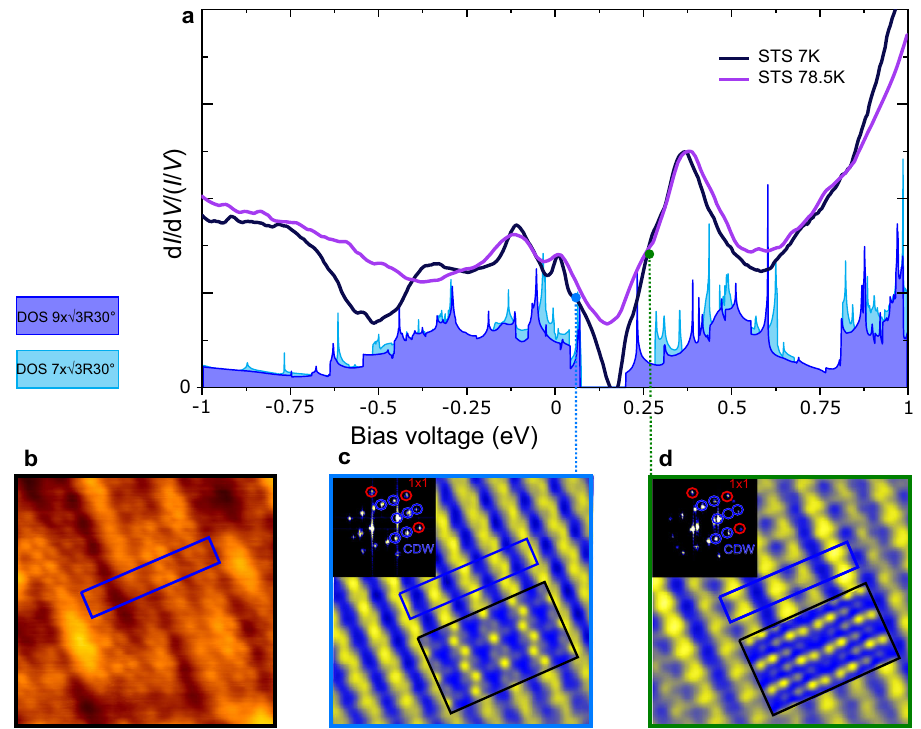
Fig. 4 Spatially and electronically resolved CDW phase in monolayer VS 2 . a Scanning tunneling spectroscopy (STS) d I /d V spectra taken with a Au tip on monolayer VS 2 at 78.5 K (purple) and 7 K (black). The spectra are plotted along with the DFT-calculated density of states (DOS) for the 7 ´ ffiffiffi p and 9 ´ 3 R30 (cid:4) (indigo) CDW phases of monolayer 1T-VS 2 . b Atomically resolved STM topograph of monolayer VS 2 taken at V t = 175 meV. c , d Fourier- fi ltered d I /d V conductance maps of the same region as in b , taken at V (minimum) color scale is used to depict the d I /d V intensity. The blue box indicates the same location in b – d and corresponds to a single 9 ´ cell of the CDW. In the same color scale, DFT-simulated d I /d V maps below ( c ) and above ( d ) the gap of the charge density wave (CDW) are overlaid as insets. The maps show the integrated DOS from 0 to 137 meV ( c ) and from 137 to 275 meV ( d ). Additionally, the Fourier transforms of the conductance maps are shown in the upper-left corners with the 1 × 1 (red) and CDW peaks (blue) highlighted by circles. Measurement parameters: f = 777.7 Hz, a T = 78.5 K, I t = 0.3 nA, V r.m.s. = 6 meV and T = 7 K, I t = 0.45 nA, V r.m.s. = 4 meV, b – d T = 7 K, 5.5 × 5.5 nm 2 , I t = 0.3 nA, V r.m.s. = 10